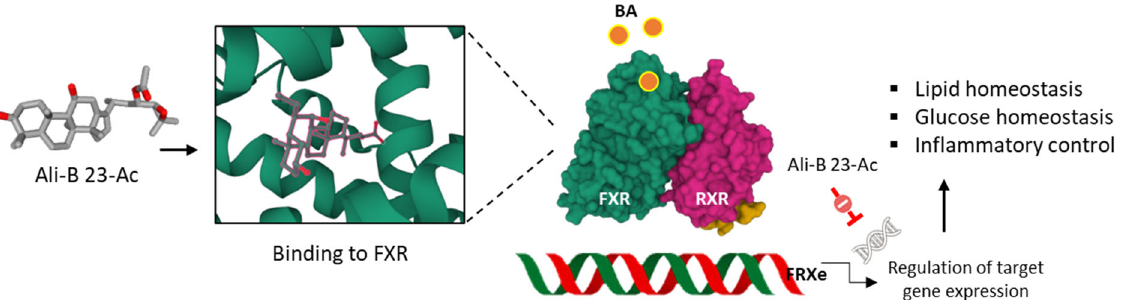
Figure 4. Anti-atherosclerosis activity of Ali-B 23-acetate. The compound binds to the FRX protein and displays an agonist activity which leads to the regulation of the expression of genes implicated in the control of inflammation, glucose, and lipid levels. Via this mechanism, Ali-B 23-acetate reduces atherosclerotic plaque.